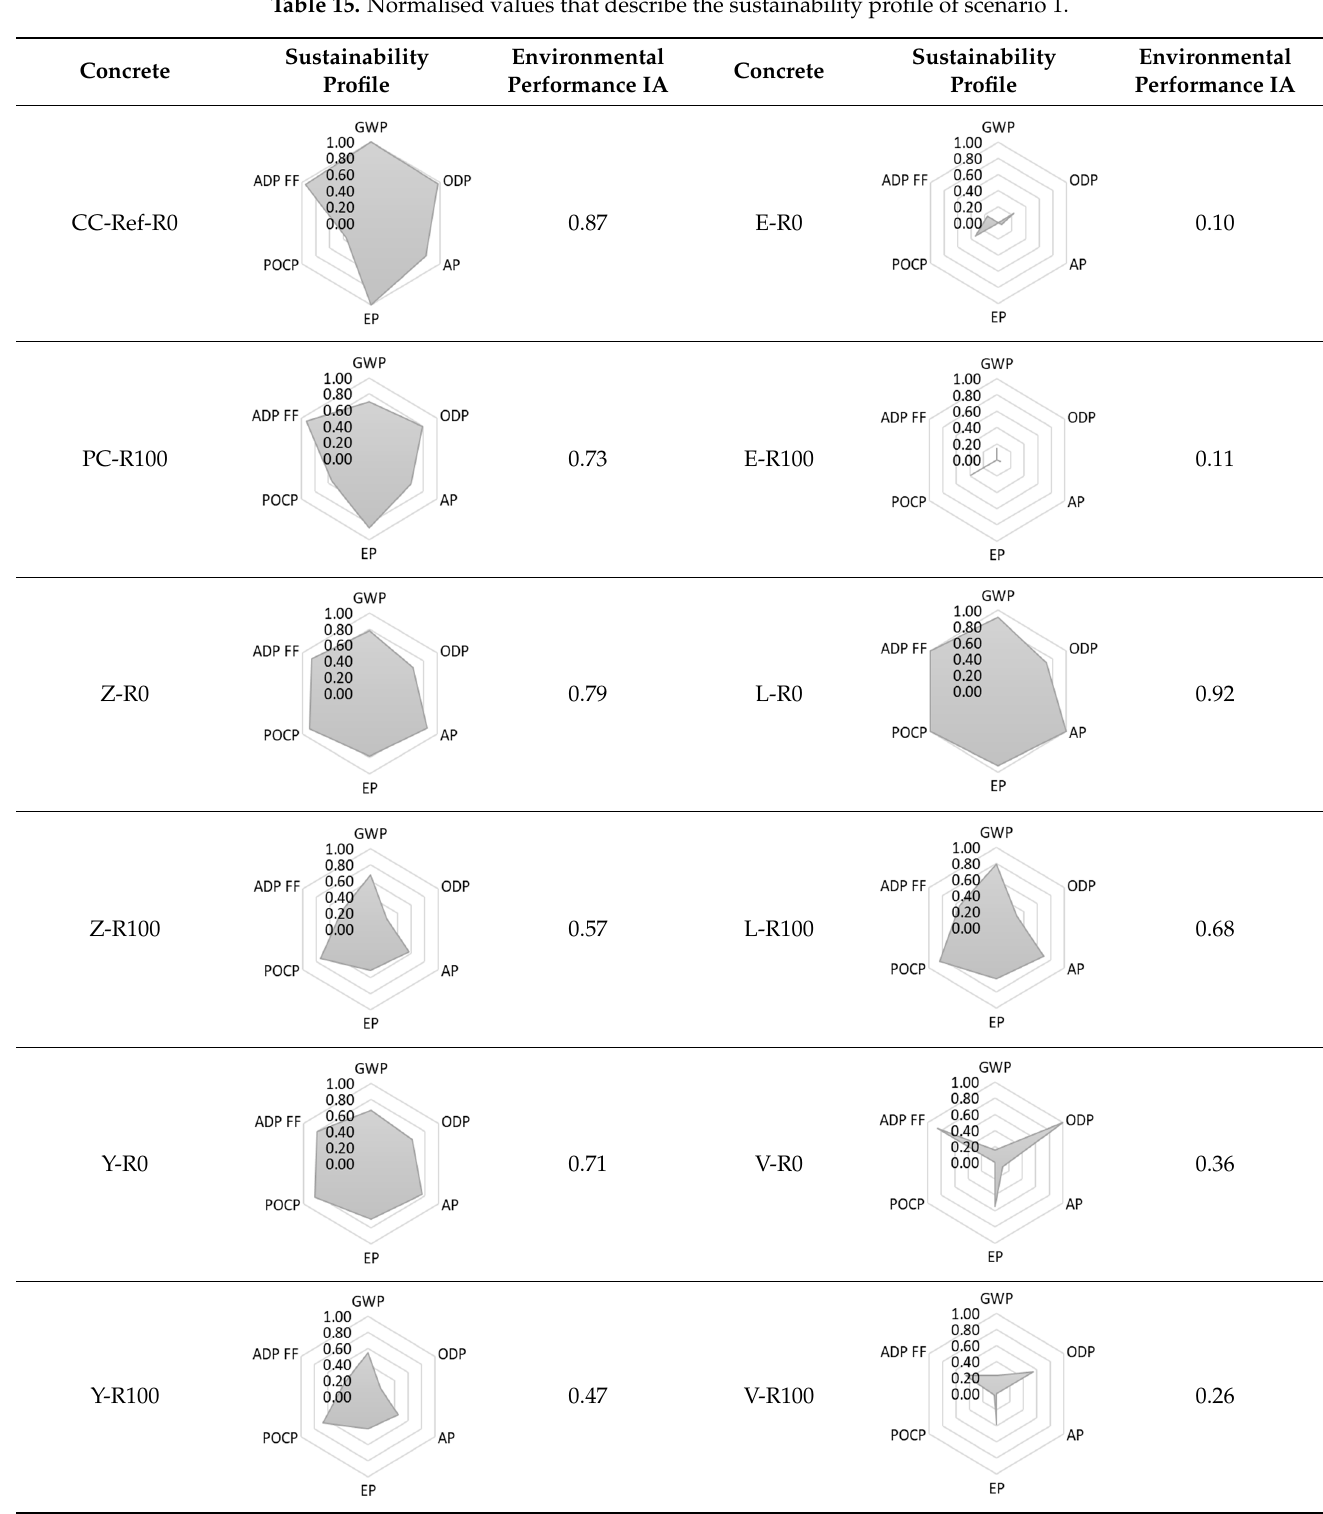
Table 15. Normalised values that describe the sustainability profile of scenario 1.